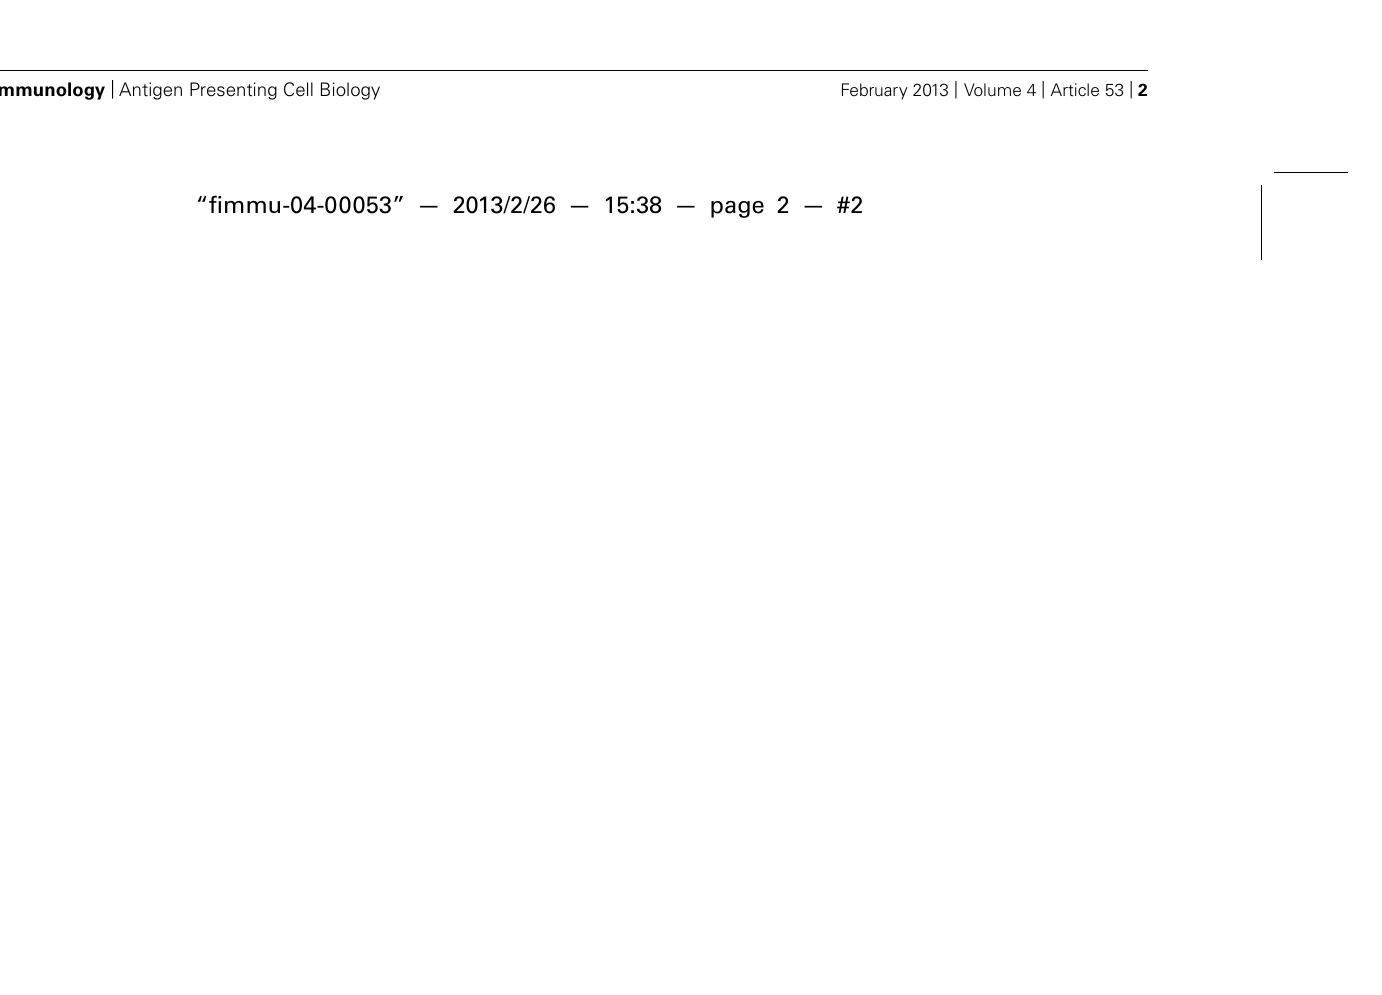
Frontiers in Immunology | Antigen Presenting Cell